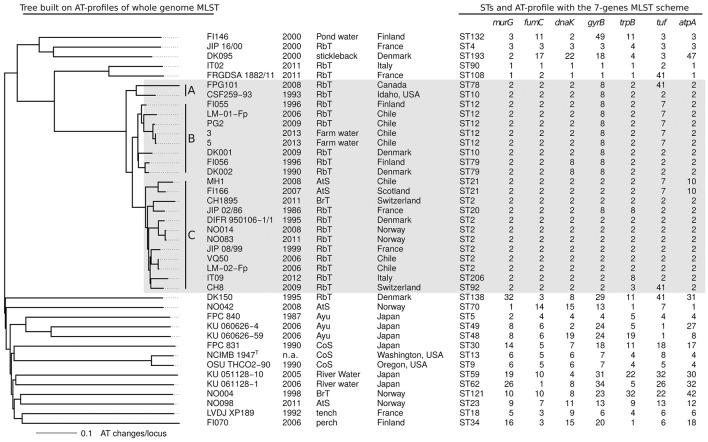
Whole-genome MLST. Neighbor-Joining tree built on pairwise distance between AT-profiles. Distance counted as the fraction of allele types that differs between two strains. Isolate name, year, host fish, and country of sampling are reported. The following abbreviations are used for the fish names: RbT for rainbow trout, CoS for coho salmon, AtS for Atlantic salmon, and BrT for brown trout. STs and AT-profiles corresponding to the classical 7-genes MLST scheme are also shown. CC-ST10 is highlighted by a light gray box.